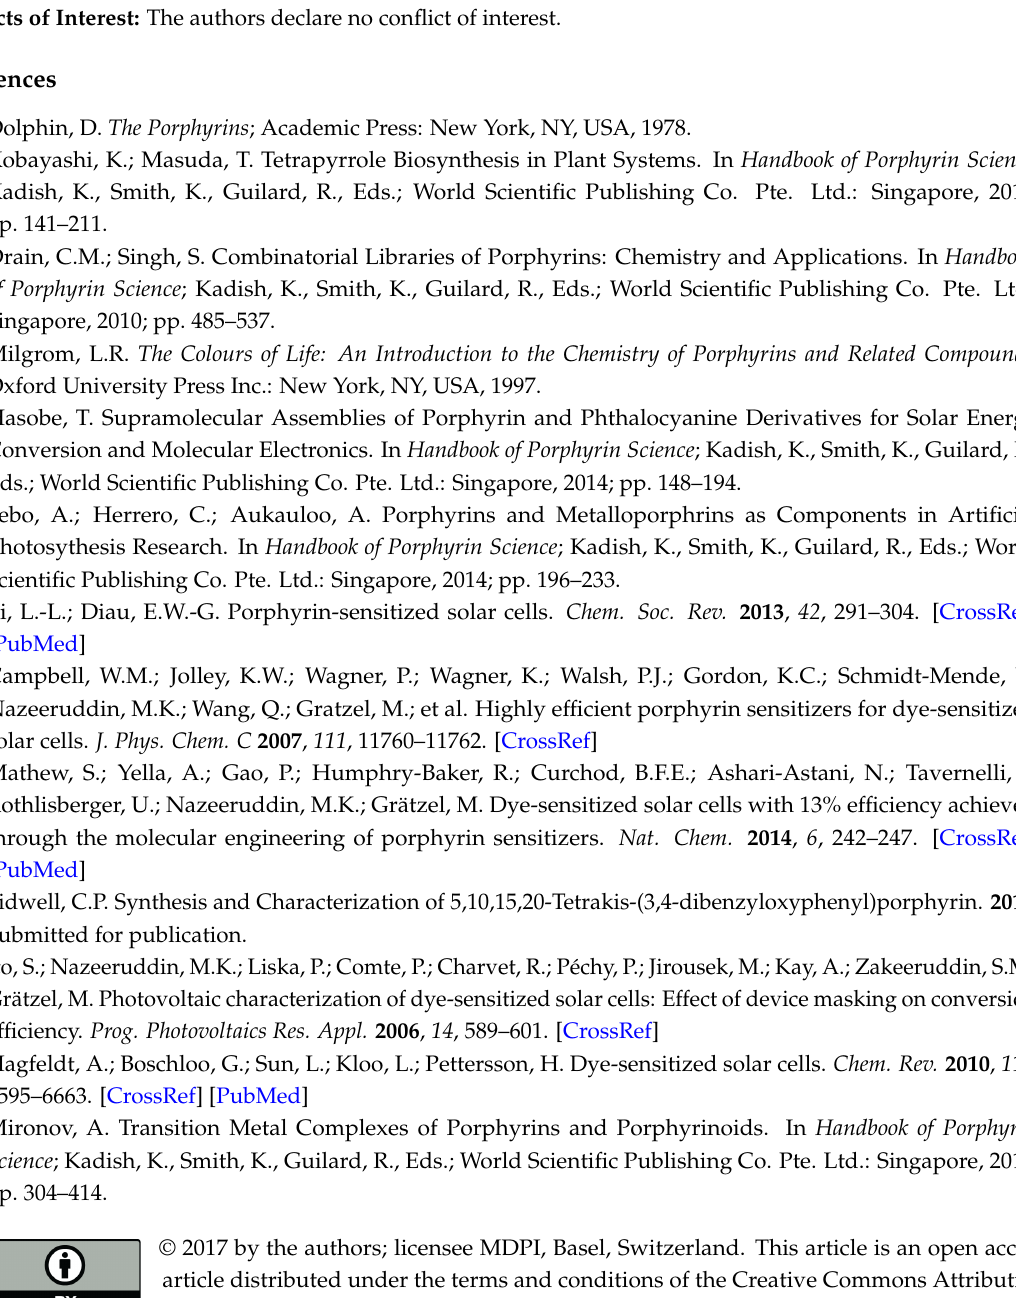
Figure S2: Comparison of theoretical isotopic distribution to experimental data. Figure S3: Electronic spectra before and after metalation; Table S1: Open circuit voltage of CuTDBOPP solar